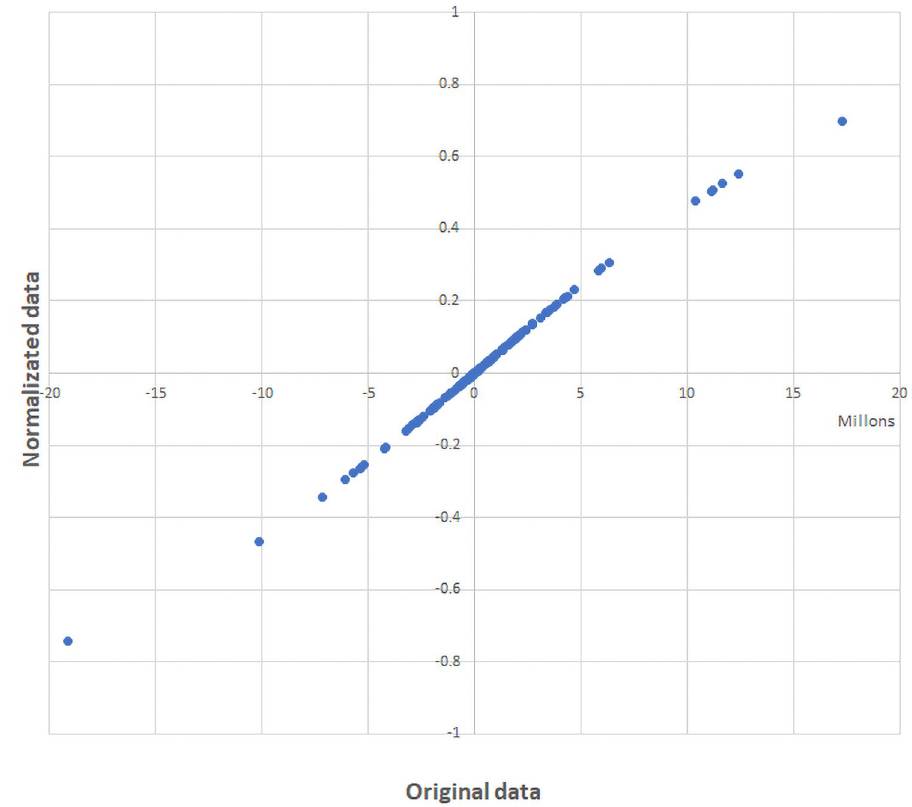
Fig 12. Response curve of normalized data of specific